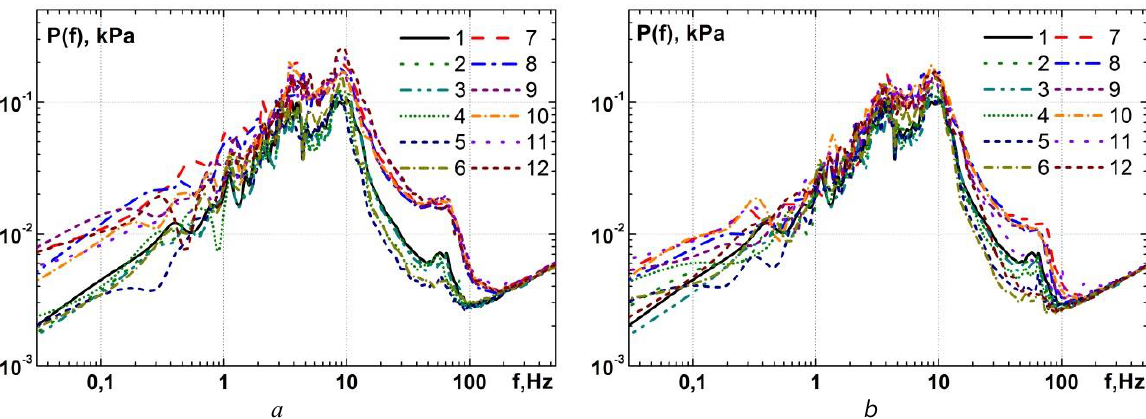
а b Figure 8. Pre-multiplied power spectral densities of the pressure fluctuations near the side jet (a) and near the central jet (b) for the pure water flow through the open and semi-closed bileaflet heart valve The power spectral densities of the pressure fluctuations near the side jet of the aqueous solution of glycerol (43% glycerol and 57% water) through the open and semi-closed valve are presented in Figure 7b. Here, curves 1-3 are measured for the open valve, curves 4-6 are measured for the semi-closed valve, and curve 7 is an ambient noise. Curves 1 and 4 are obtained in the near wake of the valve at the distance x = d from the valve, curves 2 and 5 - x =1.1 d and curves 3 and 6 - x =1.2 d . Here, as in Figure 7a, there is a significant difference in the spectra of the pressure fluctuations for the semi-closed and open valve, which is proposed to be used in the diagnosis of thrombosis on the streamlined surface of the heart valve. The results showed that the intensity of the pressure fluctuations near the side jet in the near wake of the semi-closed valve is higher than the open